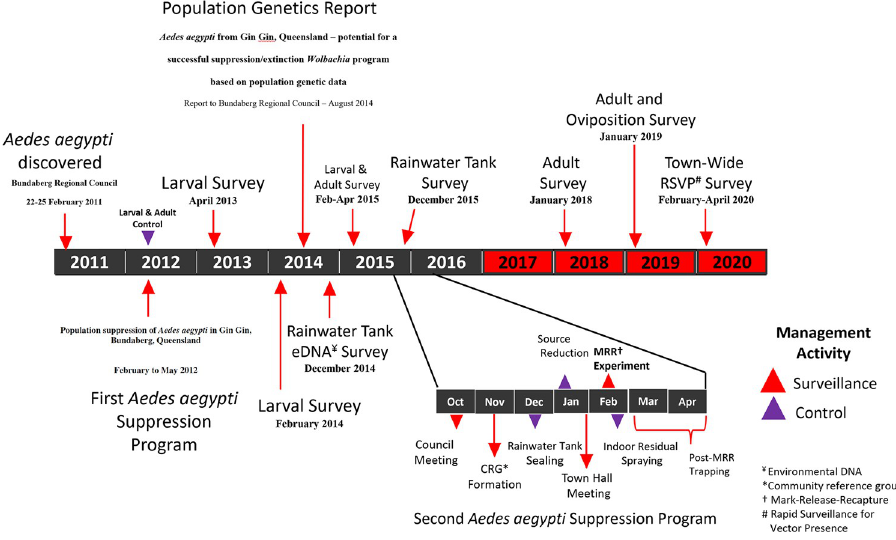
Fig 5. Timeline of surveillance and control activities which led to the elimination of Aedes aegypti from Gin Gin, Australia. Black and red bars indicate the period when Ae . aegypti was surveyed as present and not present,